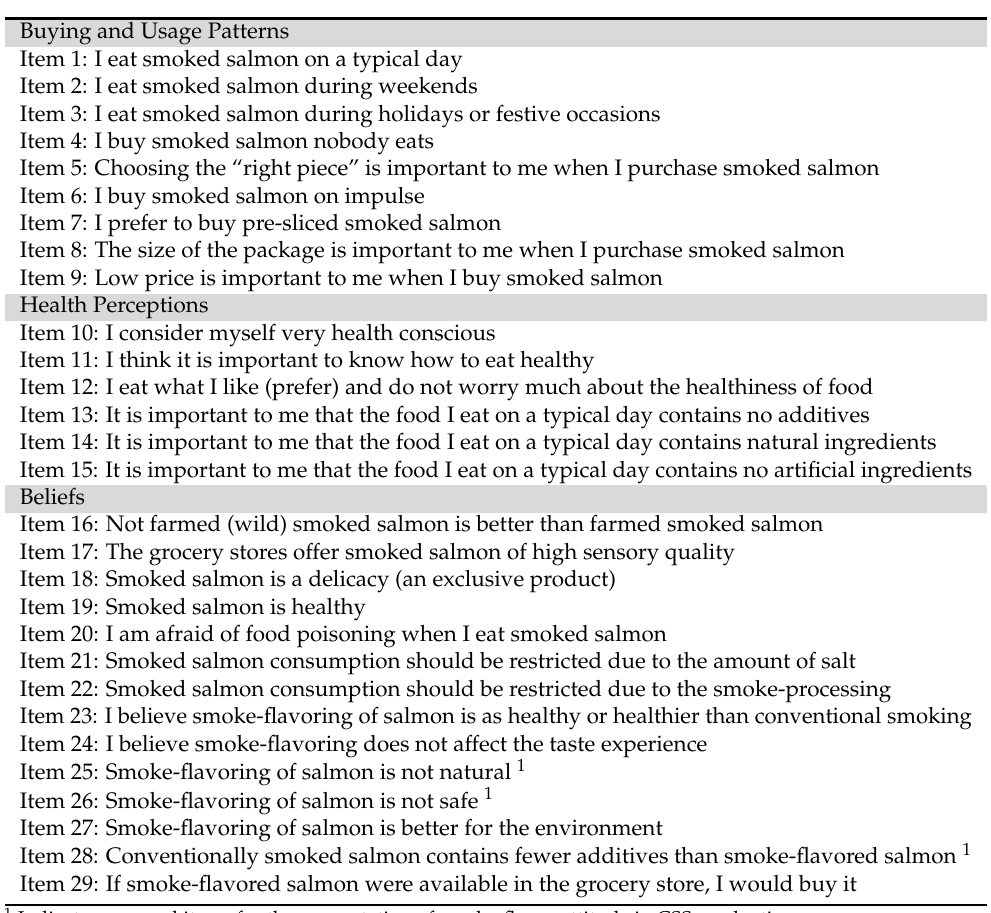
Table A1. Claims organized in three groups: buying and usage patterns, health perceptions, and beliefs towards smoked salmon and smoke-flavoring. Buying and Usage Patterns